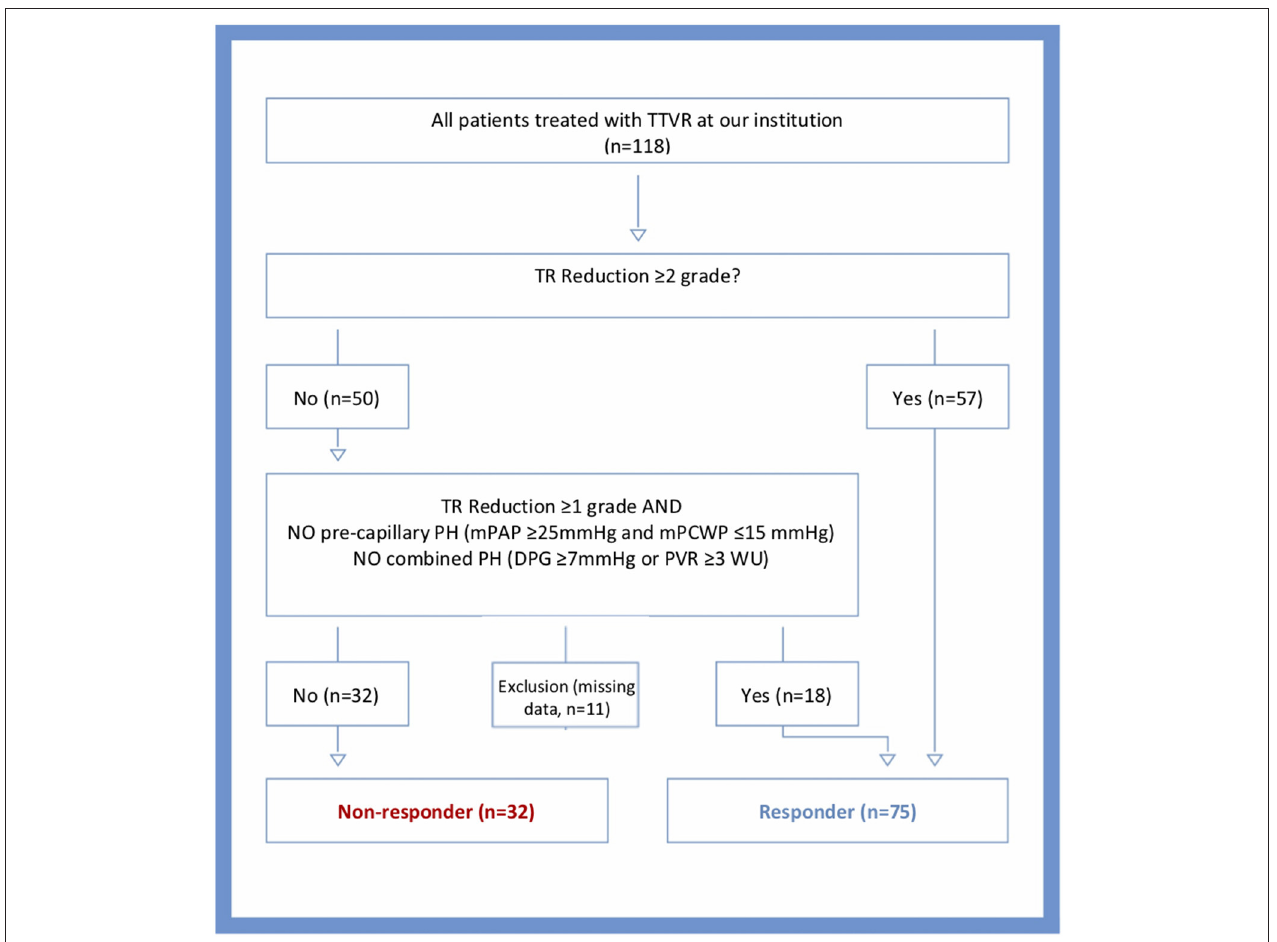
FIGURE 1 | Algorithm for the allocation of patients to responders or non-responders. TTVR, transcatheter tricuspid valve repair; TR, tricuspid regurgitation; PH, pulmonary hypertension; mPCWP, mean pulmonary capillary Wedge pressure; DPG, diastolic pulmonary gradient; PVR, pulmonary vascular resistance; WU, Wood